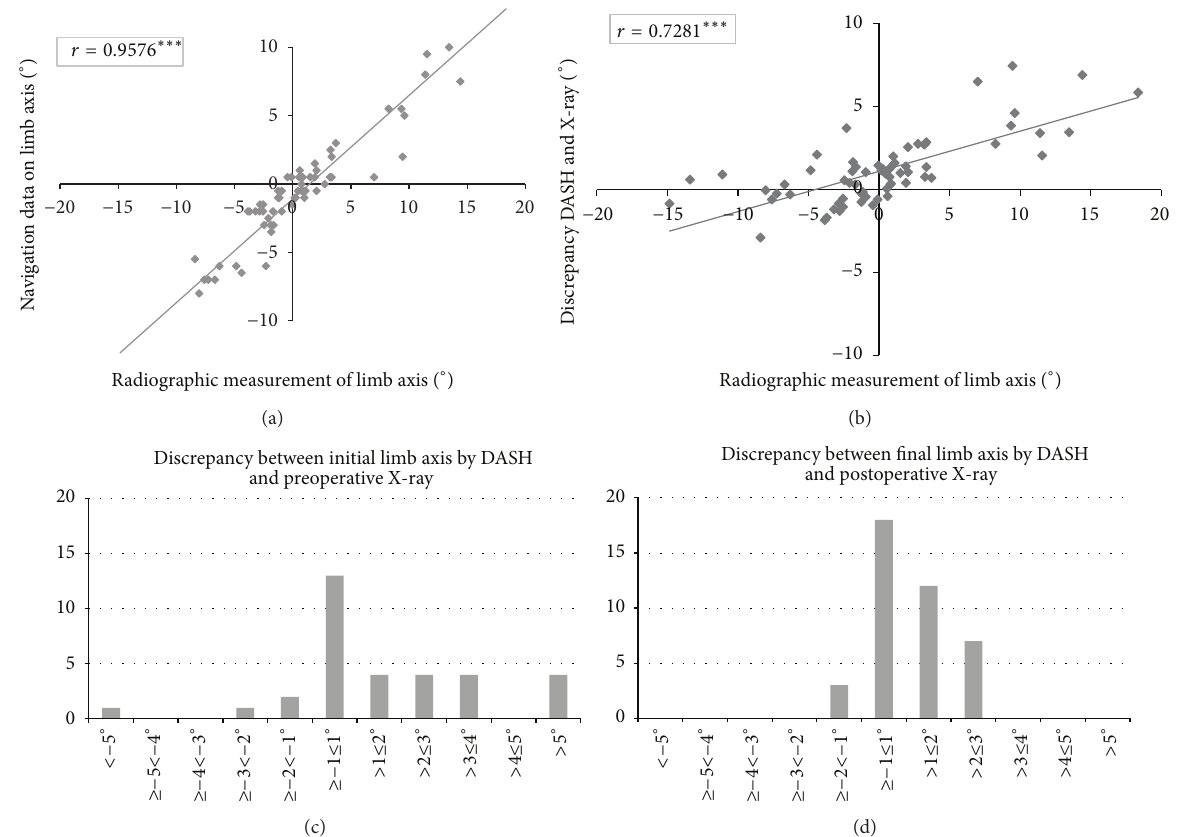
Figure 4: (a) Correlation between radiographic and navigation alignment measurements, shown as Pearson’s correlation. ∗∗∗ 𝑝 < 0.0001 . (b) Correlation between limb axis by X-ray and discrepancy between radiographic and navigation measurements, shown as Pearson’s correlation. ∗∗∗ 𝑝 < 0.0001 . (c) Distribution of the discrepancy between the preoperative mechanical axis by X-ray and the first intraoperatively measured limb axis by the navigation system. 𝑛 = 40 . (d) Distribution of the discrepancy between the postoperative mechanical axis by X-ray and the last intraoperatively measured limb axis by the navigation system. 𝑛 = 40 .